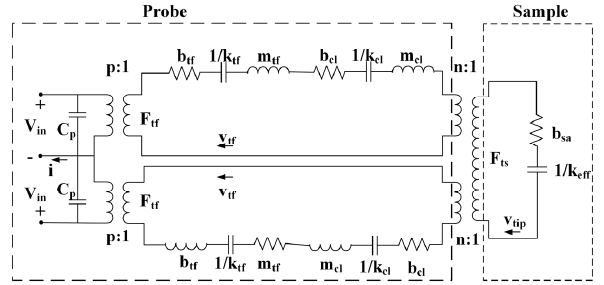
Figure 8. The transformation from cantilever to the tuning fork.